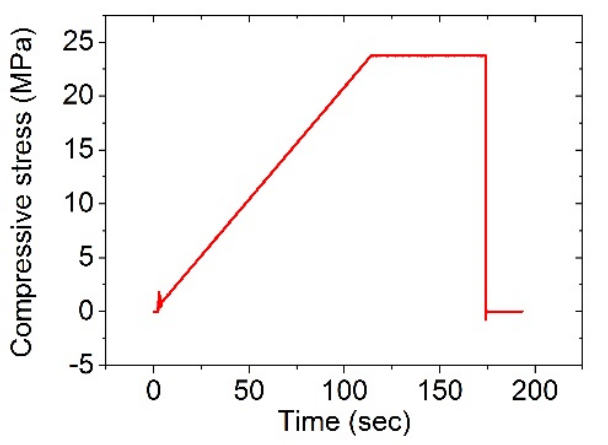
Figure A2. Pressure and peel strength curve during the pull-off test to demonstrate the adhesive strength of the PAMD-based metal electrode. The maximum pressure was 22.5 MPa, the maximum pull-off load was 0.7 MPa, and the speed at which the tape was pulled was set at 5 cm/min.